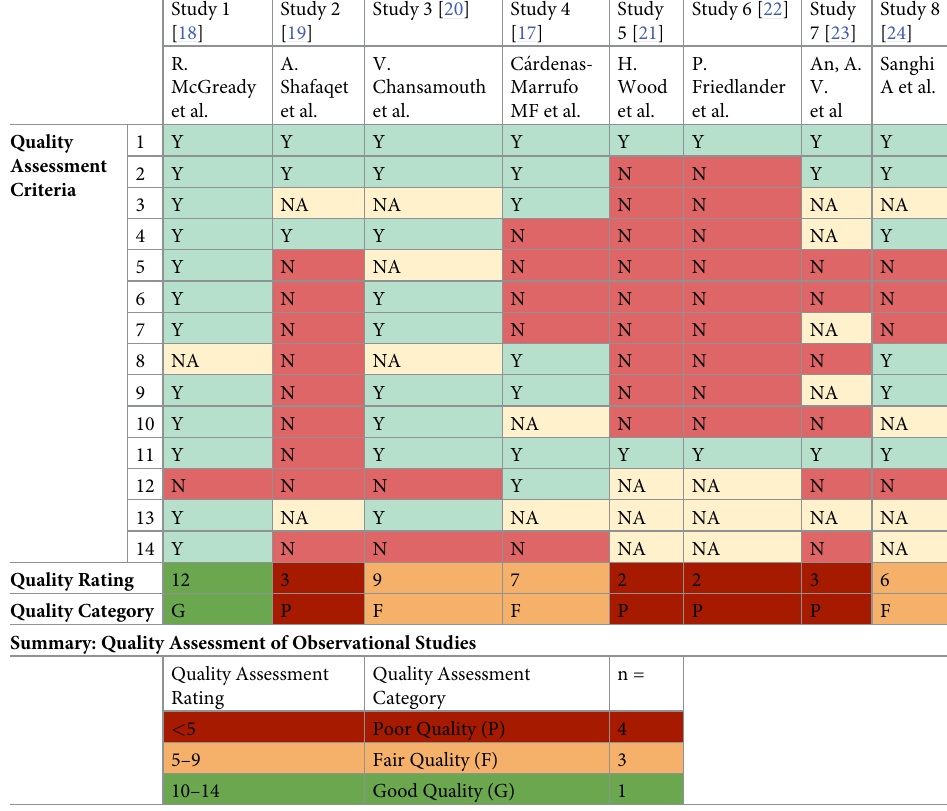
The clinical characteristics of leptospirosis in pregnancy are summarised in Table 5, includ- ing signs and symptoms, bedside and biochemical investigations, as well as reporting on car- diovascular, respiratory and liver function disturbances. The most common presenting symptom was fever with 91% of patients presenting febrile (n = 31). Other symptoms patients had were myalgia (59%, n = 17), jaundice (47%, n = 16), malaise (77%, n = 10), headache (50%, n = 11) abdominal pain (43%, n = 10) and nausea and/or vomiting (45%, n = 10). None of the women for whom relevant information was available, presented with visual distur- bances. When comparing differentials for fever, conjunctival suffusion, a sign that can some- times be used to differentiate between leptospirosis and other causes of febrile illness such as malaria [48], could be helpful in the context of pregnancy in helping distinguish between preg- nancy related disorders such as PET and HELLP and leptospirosis. Information on ocular examination was only available for 13 out of the 35 cases, and of these, 38% (n = 5) of the women had conjunctival suffusion. Complete data on all variables was not available from the included case reports and percentages were calculated after excluding missing data. From the available data, we found that nine patients had a leucocytosis (60%), 10 had a thrombocytopaenia (71%), 15 (63%) whose kidney function was affected with raised creatinine and/or oliguria and the majority had abnormal LFTs of some form (89%, n = 24). Of the 24 with the abnormal LFTs, 19 had a transaminitis, 20 had hyperbilirubinaemia, 10 had a coagu- lopathy. We were unable to categorise and grade severity of the transaminitis due to detailed information not being available for 10 of the 19 transaminitis cases.